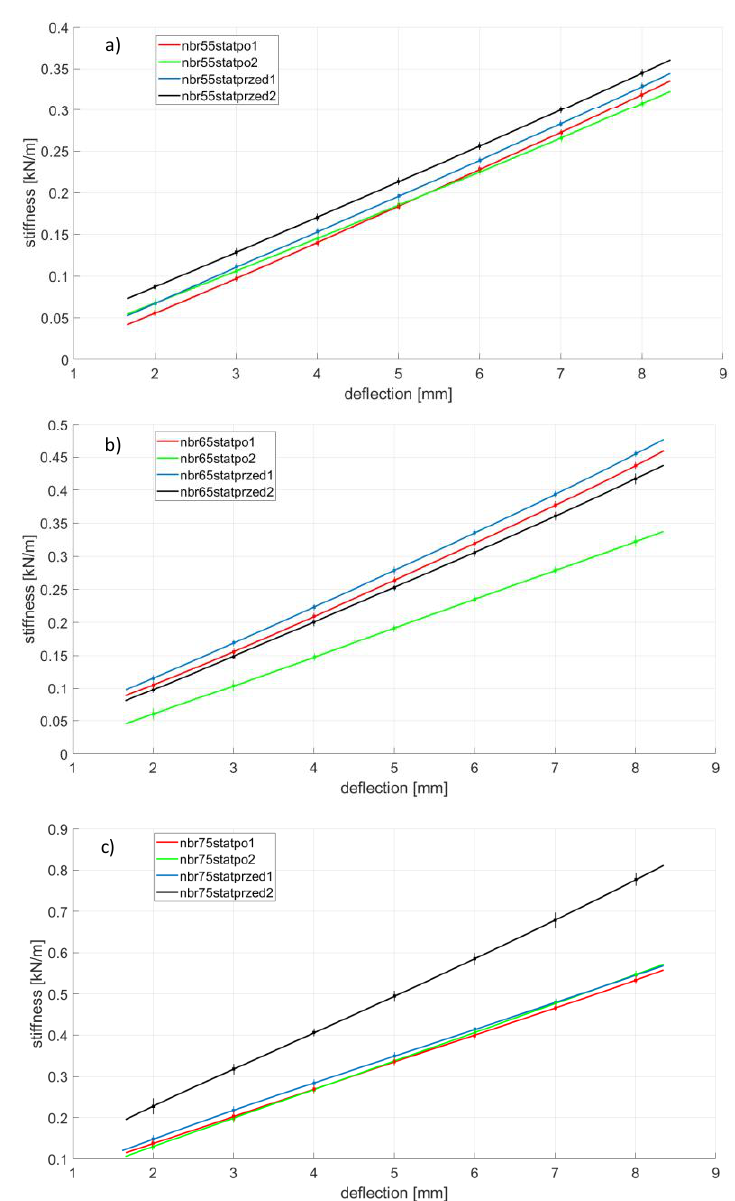
Figure 10. NBR rubber changes of stiffness during various tests conducted on the tensile machine,